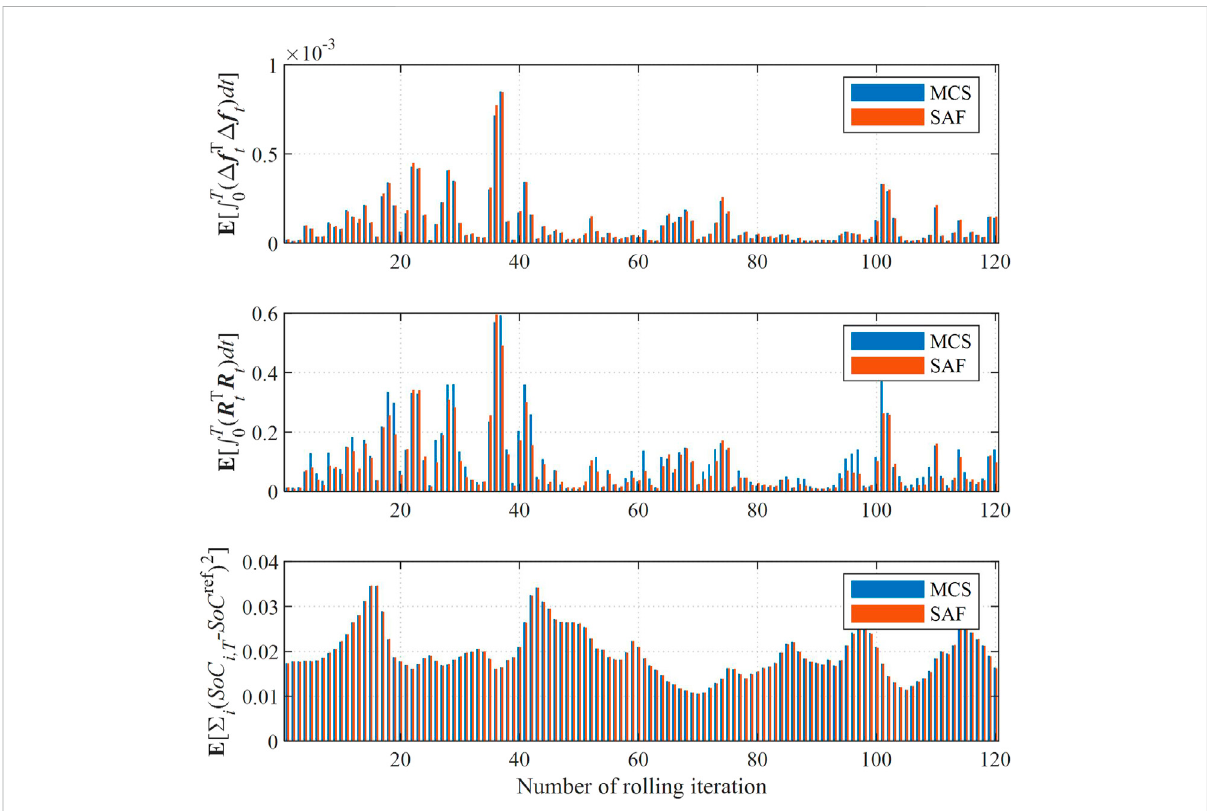
FIGURE 9 Objective value estimated by SAF compared with Monte Carlo samples: (A) objective of frequency deviations, (B) objective of control variables, and (C) objective of SoC deviations. Keywords: energy storage, frequency regulation, wind power uncertainty, stochastic optimization, Itô theory, distributed